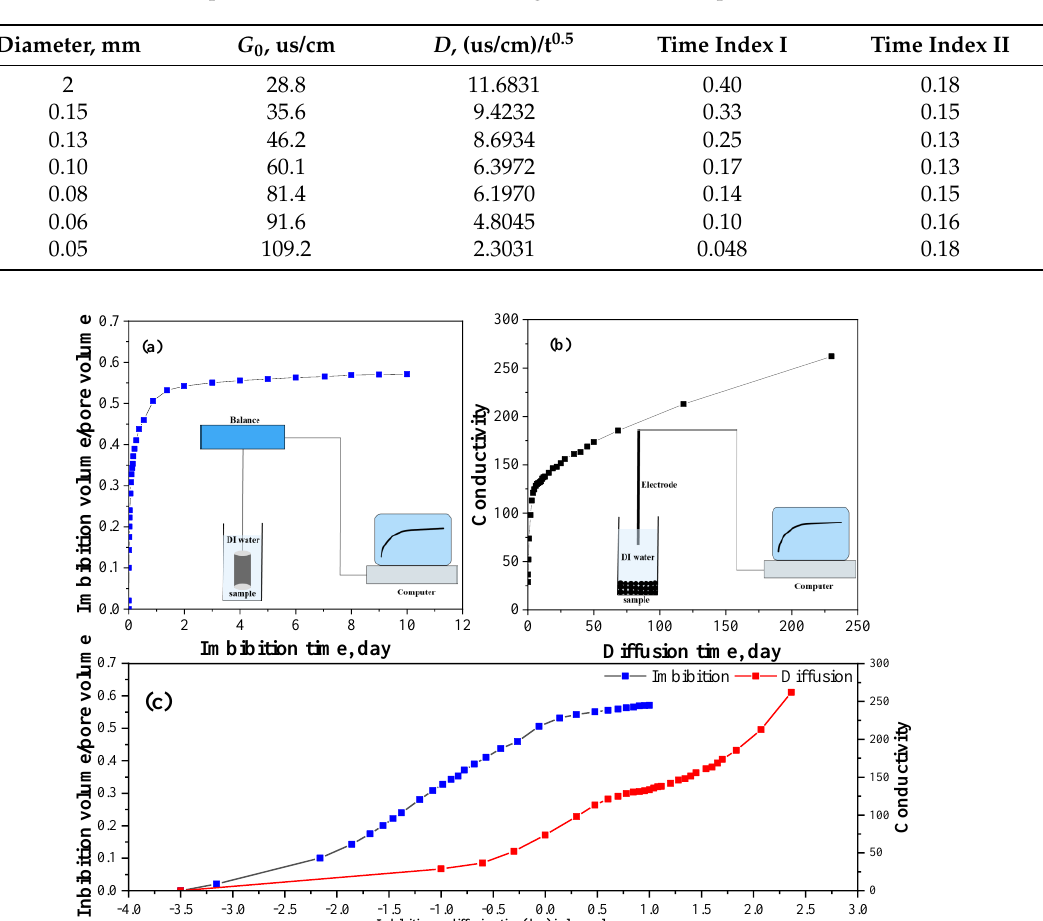
Figure 7. Imbibition and salt ion diffusion curves of sandstone sample.